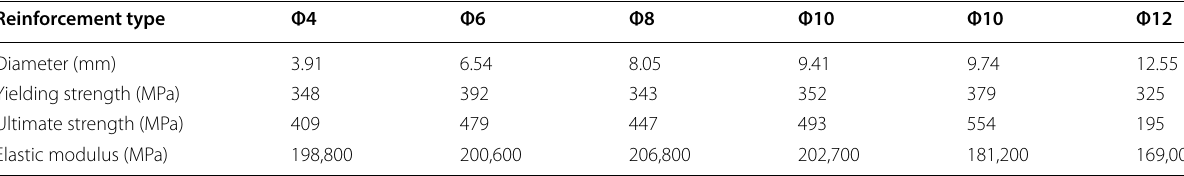
Table 3 Properties of reinforcing bars.